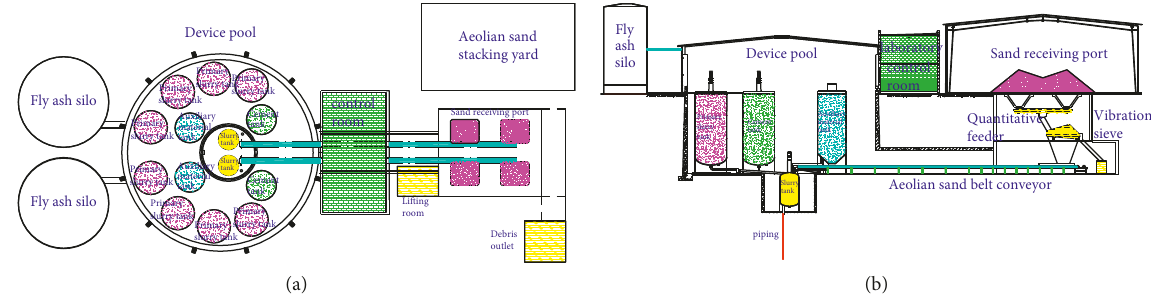
Figure 6: Layout and scene of backfill station in Yuyang coal mine. (a) Plane sketch. (b) Section diagram.